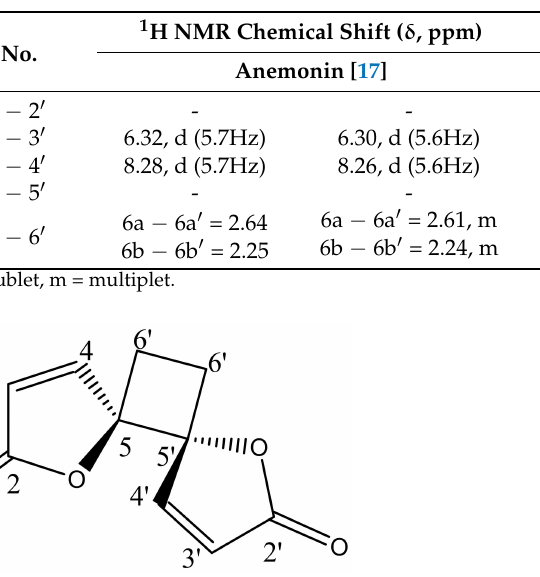
Table 3. Comparison of the 1 H-NMR and 13 C-NMR spectral data of the RM-H1 with 1 H-NMR and